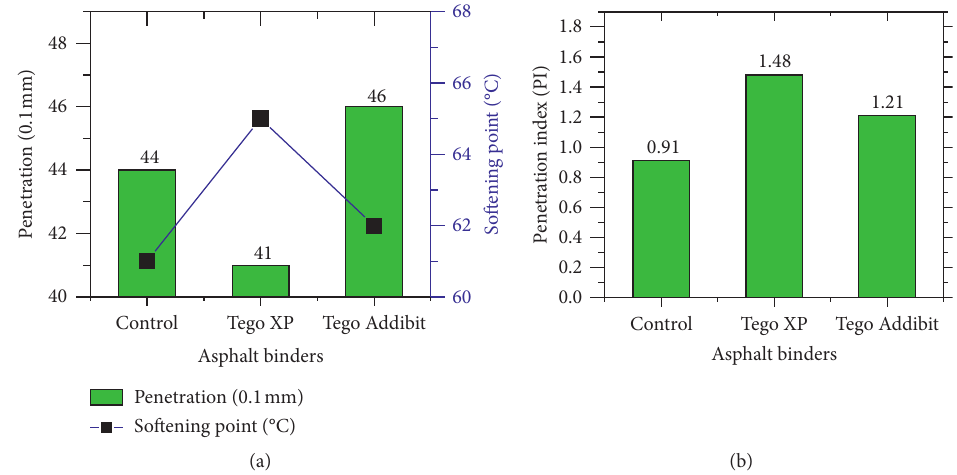
Figure 5: Conventional tests: (a) penetration at 25 ° C and softening point test and (b) penetration index (PI) of rubberized